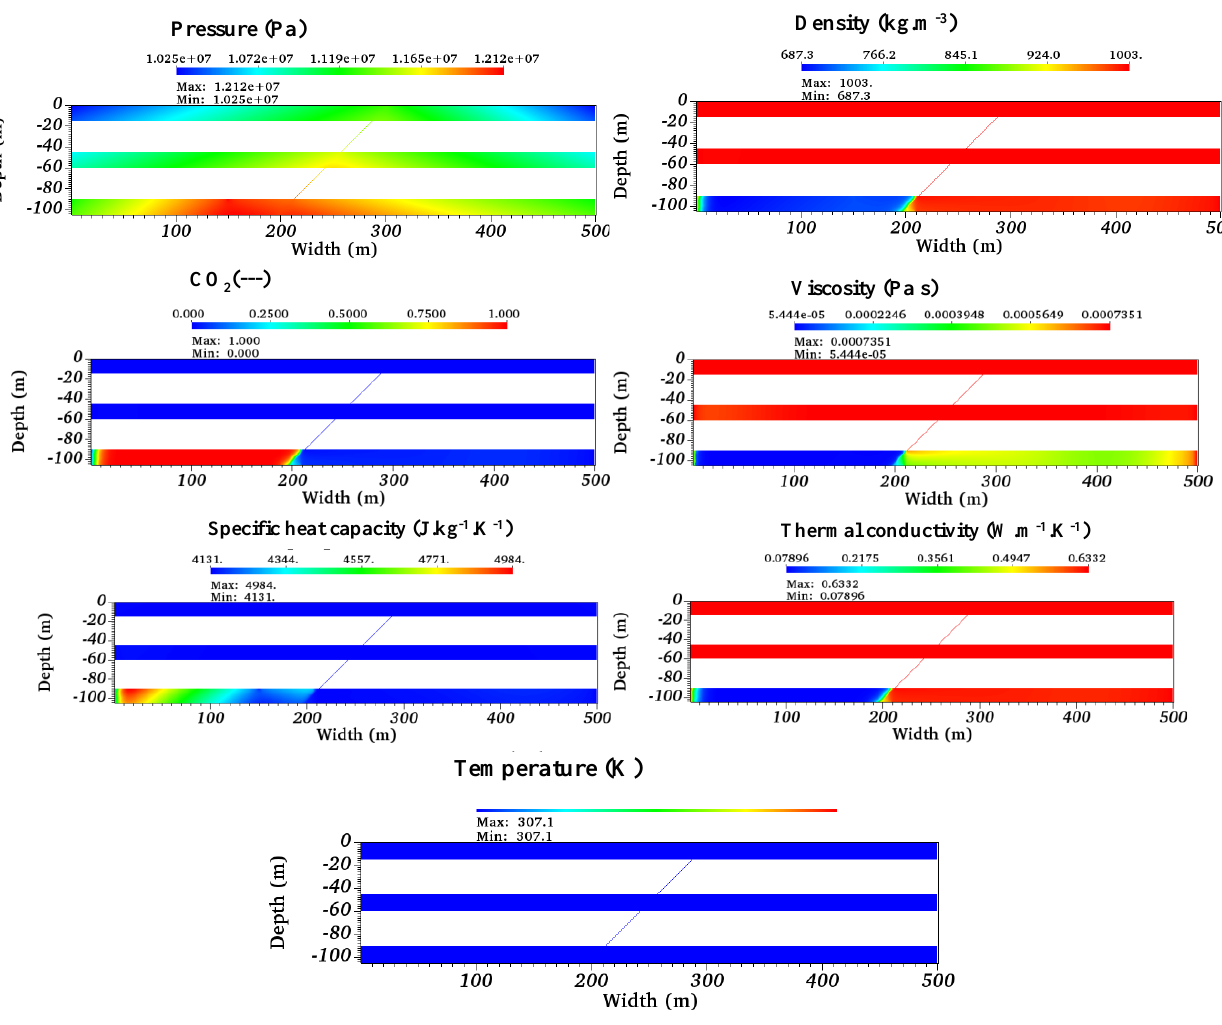
Figure 9. Distribution of pressure, density, CO 2 , viscosity, specific heat capacity, thermal conductiv- ity, and temperature after 300 days of injection for the case with thermal gradient = 0.03, injection rate = 0.41319 m 3 /s, 𝛼 𝑙 = 5 and 𝛼 𝑡 = 0.5 and fracture aperture = 100 µm.